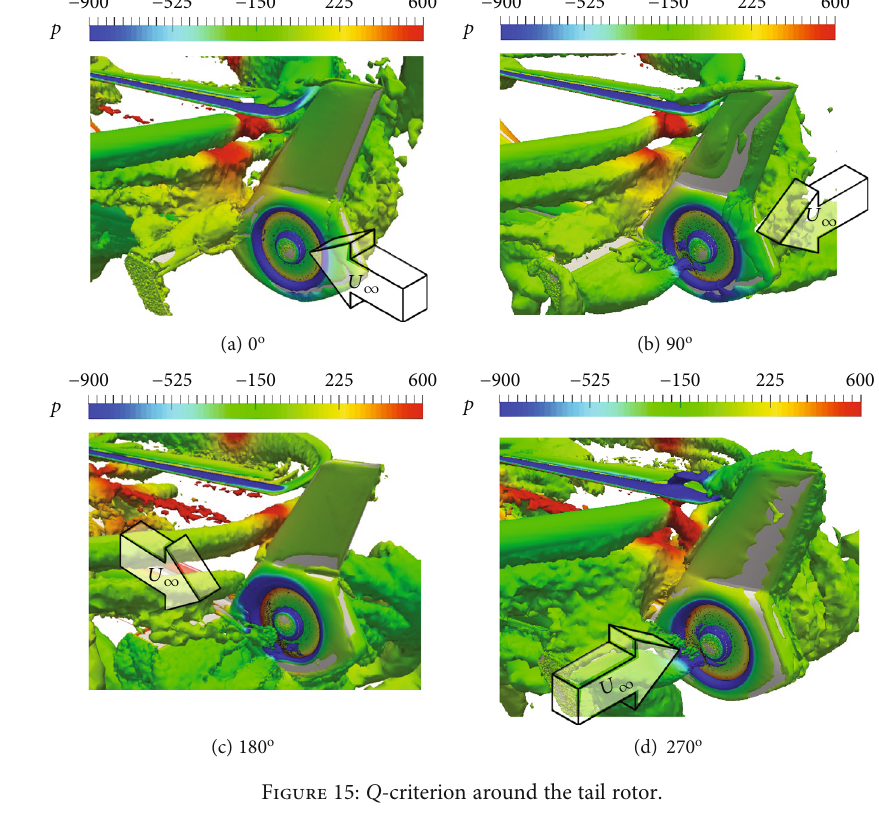
Figure 15: Q -criterion around the tail rotor.